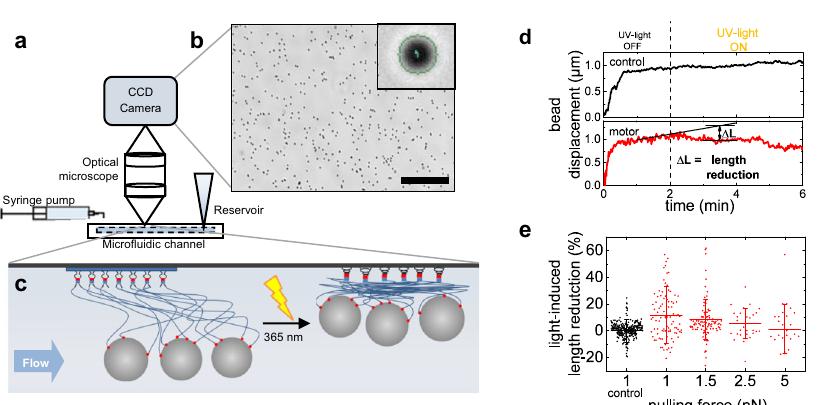
Fig. 2 Mechanical force generated by rotatory motor can trigger TCR signaling. a Schematic of manufacture and activation of anti-CD3 antibody linked to the substrate via rotatable motor (Motor) or non-rotatable motor (Ctrl). The red box represents the motor-receptor interface at the immunological synapse. Ten UV pulses were applied within 60 s to activate the motor. b – e Ca 2 + in fl ux is induced by activation of the motor. Either Jurkat T cells ( b , c ) or primary human CD4 + T cells ( d , e ) loaded with Fluo-4-AM were settled on motor substrate for 20 min prior to UV illumination (starting at time 0). Duration of UV pulses was 1 s. Exemplary cells and Ca 2 + traces are shown in ( b ) and ( d ). Ca 2 + in fl ux ( Δ Peak) was analyzed in c (Ctrl, n = 137 cells from six independent experiments; Motor, n = 153 cells from nine independent experiments) and e (Ctrl, n = 42 cells from two independent experiments; Motor, n = 46 cells from three independent experiments). f – i Shorter or longer duration of UV pulses cannot induce Ca 2 + in fl ux. We used Jurkat cells and applied UV pulses with either shorter duration of 0.5 s ( f , g Ctrl, n = 119 cells from fi ve independent experiments; Motor, n = 201 cells from nine independent experiments) or extended duration of 2 s ( h , i Ctrl, n = 101 cells from fi ve independent experiments; Motor, n = 172 cells from nine independent experiments). LUT min and max given in a.u. to visually compare motor vs control substrate within the same condition only. Data in ( c ), ( g ), ( e ), and ( i ), represent mean ± s.e.m. Data from motor and control motor substrates were compared using an unpaired two-tailed Student ’ s t -test. Scale bars are 10 µ m.